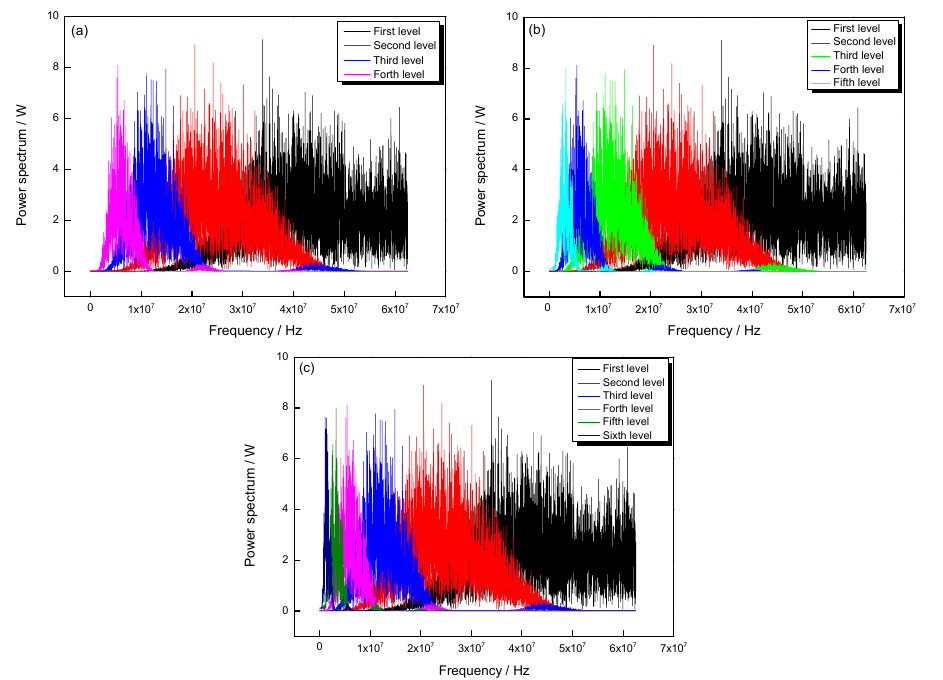
Figure 5. The frequency domain of L cr wave with different decomposition levels. ( a ) Four levels, ( b ) five levels, ( c ) six levels.